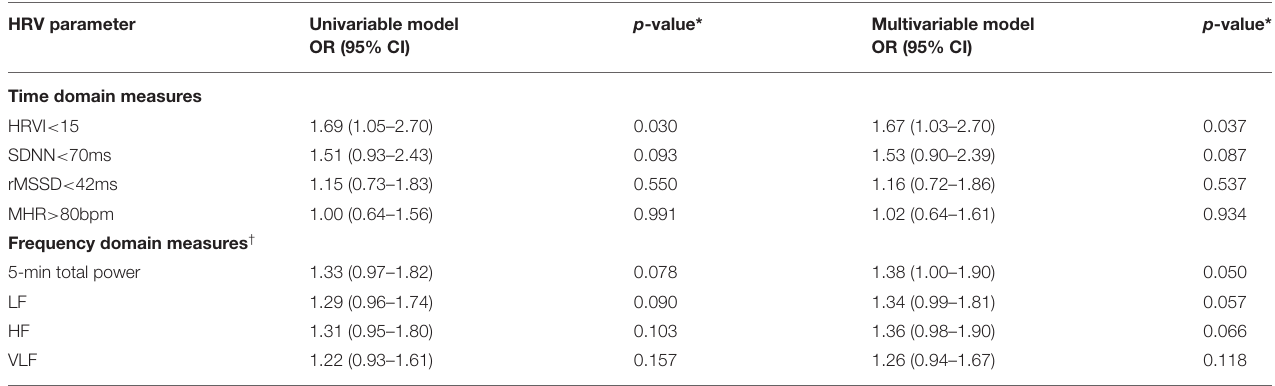
TABLE 2 | Association of heart rate variability and presence of silent brain infarcts in the sinus rhythm group. HRV parameter